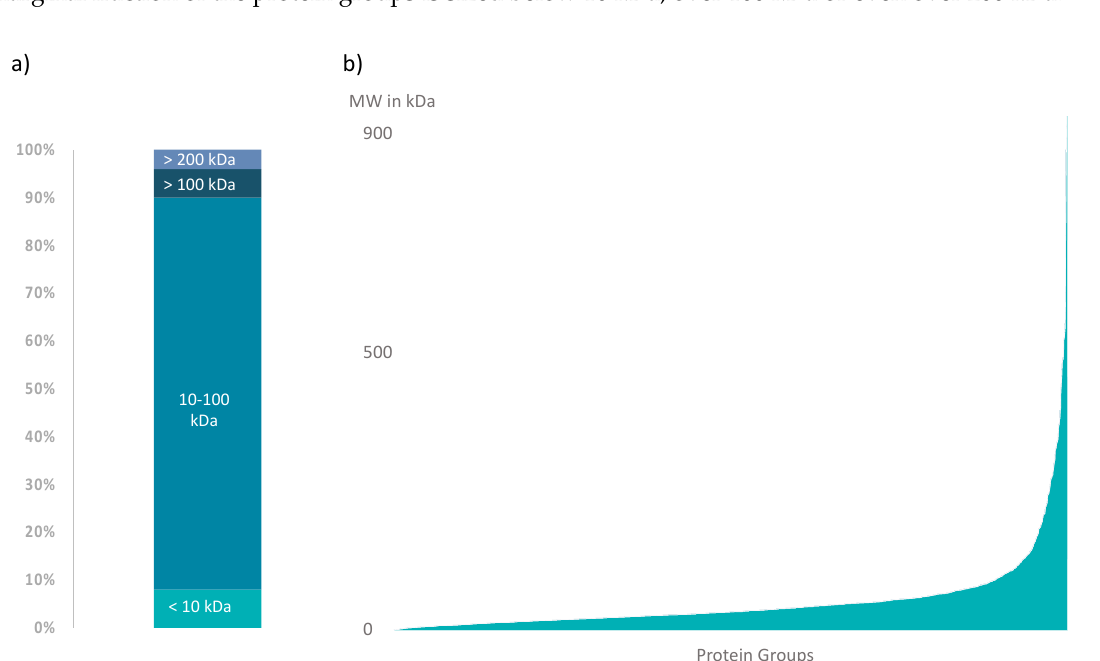
Figure 3. Size distribution within the A. bruennichi venom proteome. ( a ) Relative distribution of the identified protein groups within the proteome. Small protein groups of <10 kDa account for 8%, and protein groups between 10 kDa and 100 kDa account for 82%, while protein groups larger than 100 kDa and larger than 200 kDa contribute 6% and 4%, respectively, to the proteomic dataset. ( b ) Absolute size distribution of identified protein groups in kDa.